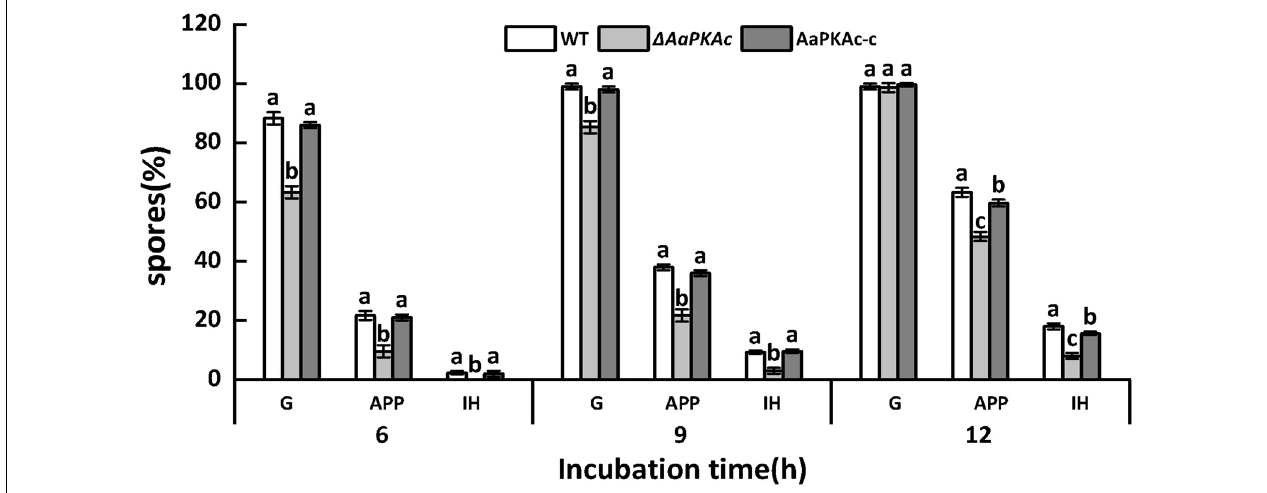
FIGURE 3 | Effect of AaPKAc on spore germination rate (G), appressorium formation rate (APP), and infection hyphae (IH) of the wild-type strain (WT), (cid:49) AaPKAc mutant, and AaPKAc genetic complementation strain (AaPKAc-c) on the pear epidermis. Vertical lines indicate standard error ( ± SE); different letters indicate significant differences among treatments ( P <